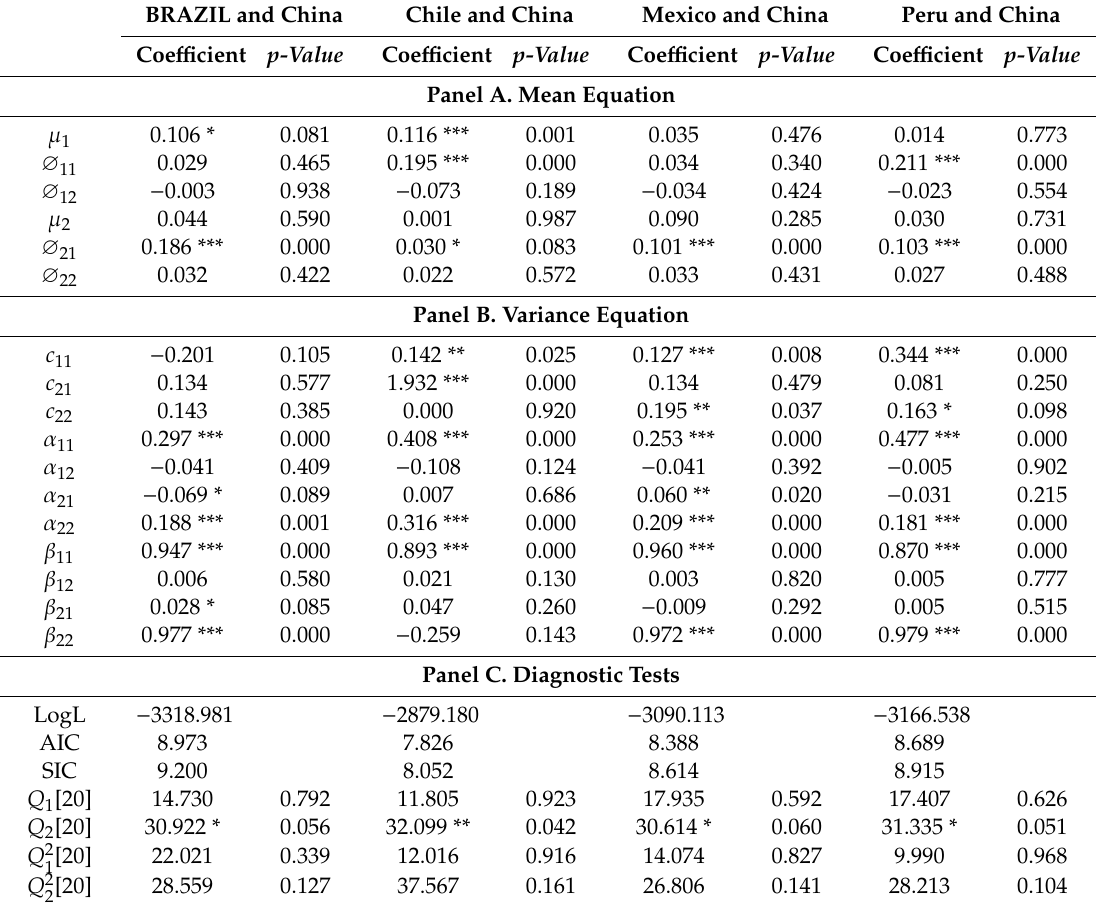
Table 7. Estimates of BEKK-GARCH for the China and Latin American stock markets during the global financial crisis.